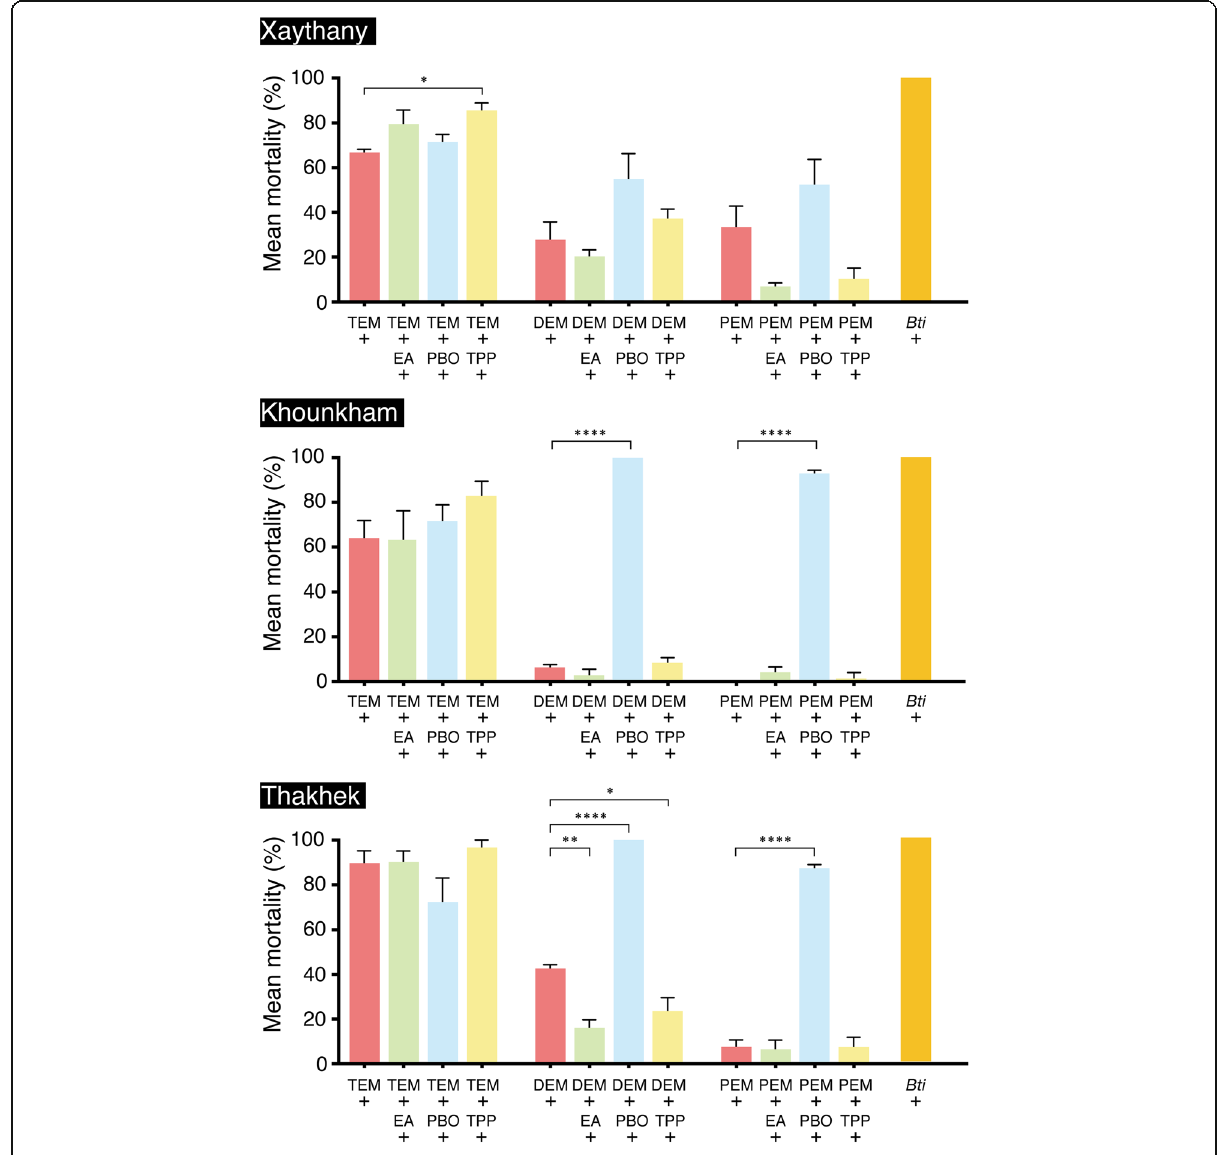
Fig. 2 Comparison of the mortality rates of Ae. aegypti larvae treated with different insecticides and synergists. Ordinary one-way ANOVA and Dunnett ’ s multiple comparisons test, with a single pooled variance, were used for the analyses. Significant differences in mortality rates between the groups treated with an insecticide alone and those treated with an insecticide plus a synergist is indicated by asterisks. * p < 0.05, ** p < 0.01, **** p < 0.0001; TEM: temephos, DEM: deltamethrin, PEM: